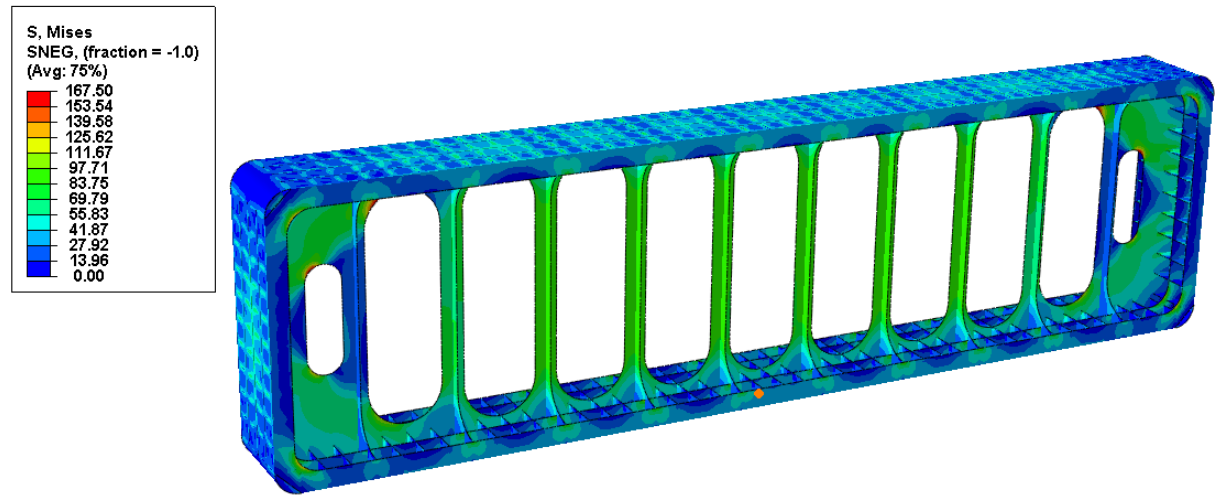
Figure 6. Results of finite element analysis.